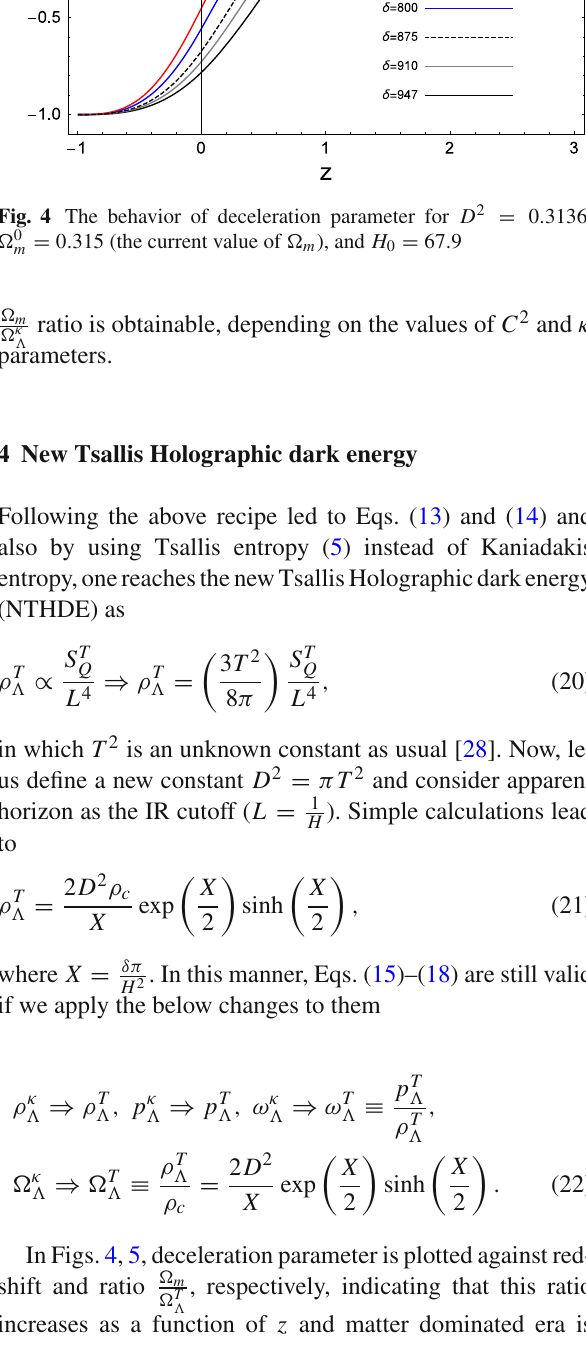
. For example, for 3